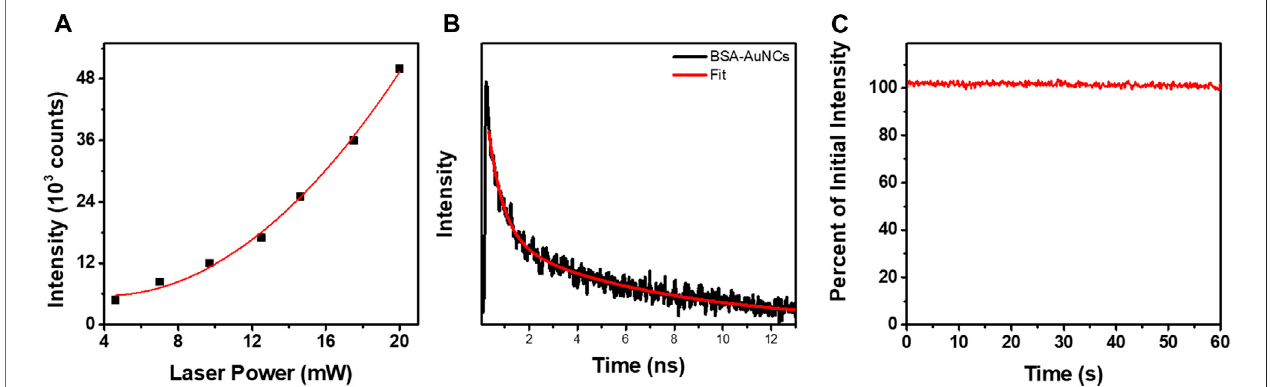
FIGURE 5 | (A) Quadratic dependency of the TPE PL intensity of entire BSA-AuNCs micro fl ake powder on the laser power (5 – 20 mW). The (B) TPE lifetime decay obtained for BSA-AuNCs micro fl ake powder at an excitation of 810 nm (5 mW). The intensity of the lifetime decay is presented in a logarithmic scale. (C) The photostability of BSA-AuNCs micro fl ake powder under continuous pulsed excitation at 810 nm for 1 min.